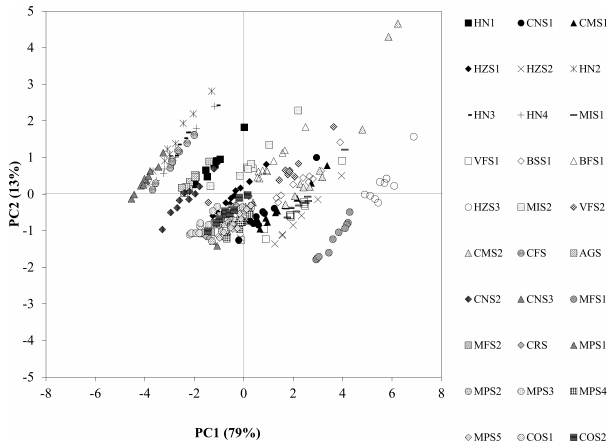
Fig. 4. PCA of syrup spectra.